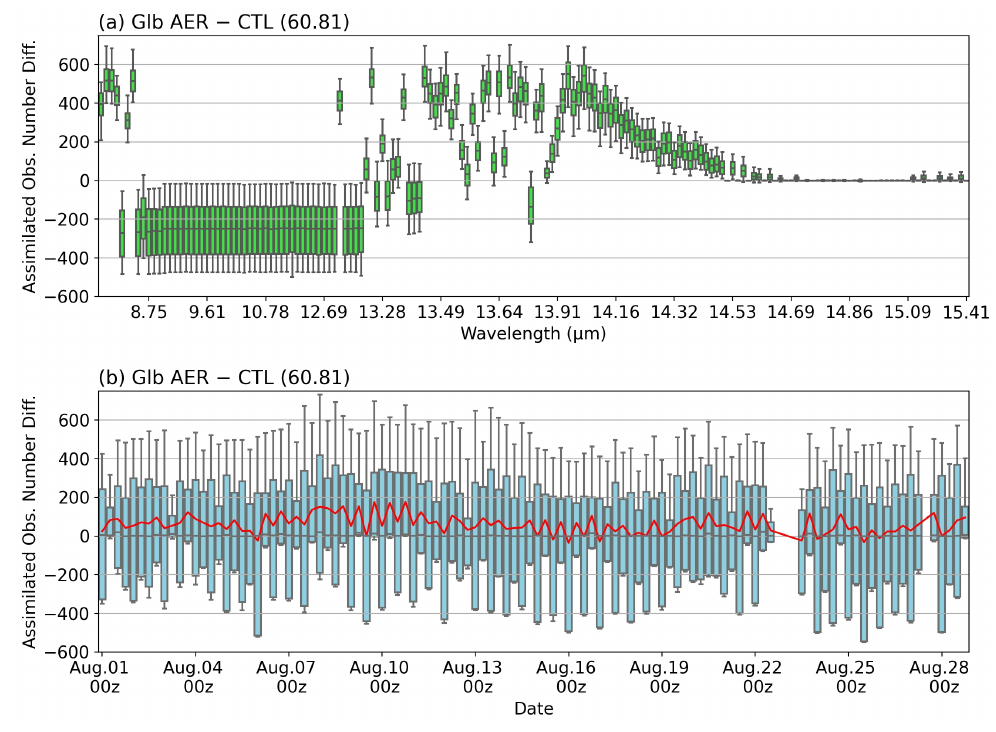
Figure 11. Boxplots for assimilated observation number difference (AER minus CTL) from IASI on MetOp-A in ( a ) the distribution of analysis cycles along assimilated channels and ( b ) the distribution of assimilated channels along analysis cycles. The 5th, 25th, 50th, 75th, and 95th percentile are displayed. Red line in ( b ) is the average value over all the assimilated